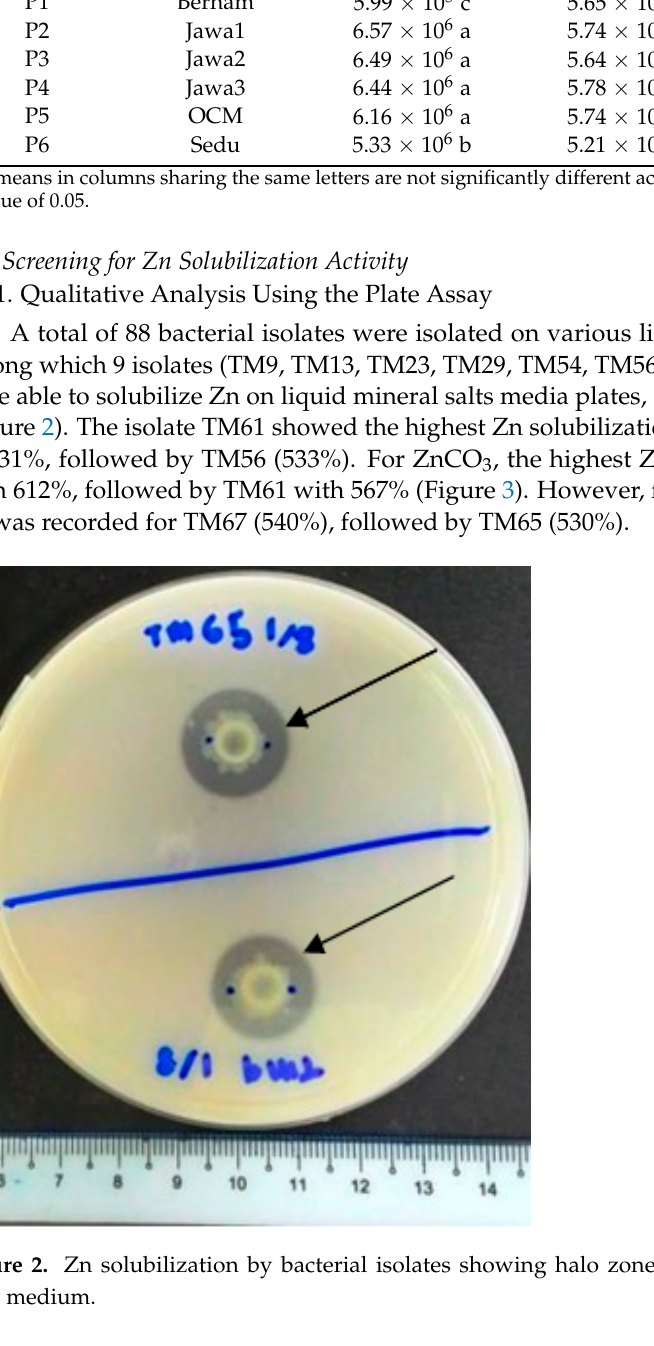
Figure 3. Zn solubilization efficiency (SE) of isolates on various mineral salts agar media. 3.3.2. Quantitative Analysis of Zn Solubilization Using Various Mineral Salts Broth As- says The ability of the ZSB to solubilize 0.1% of the various forms of insoluble Zn (i.e., ZnO, ZnCO 3 , and Zn 3 (PO 4 ) 2 ) was quantitatively determined while growing in liquid min- eral salts broth media, and the results are shown in Table 5. For ZnO, TM56 had the high- est solubilization ability (20.3%), while in ZnCO 3 -modified broth culture, TM29 had the highest solubilization (13.98%) compared to the other isolates. However, TM23 demon- strated the highest (20.99%) Zn 3 (PO 4 ) 2 solubilization ability. Most of the isolates could sol- ubilize Zn in all modified broth assays, and the lowest Zn solubility was observed in ZnCO 3 media.